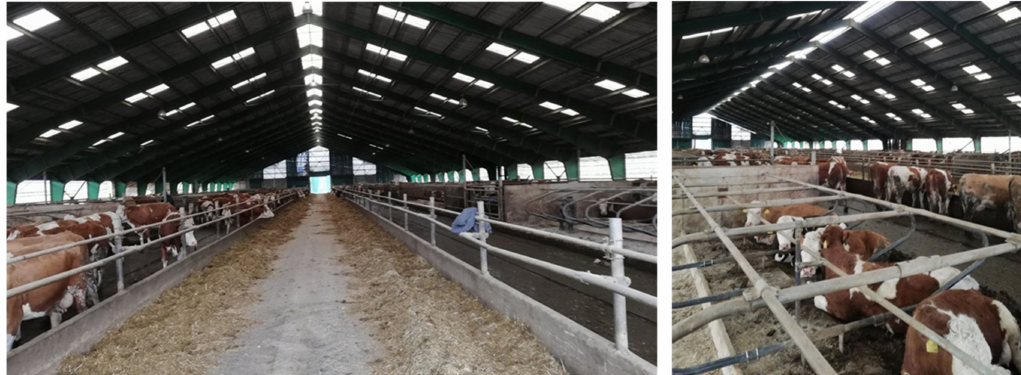
Figure 2. From left: Stall with feed space and cubicle beds. Photo by Zigo F.